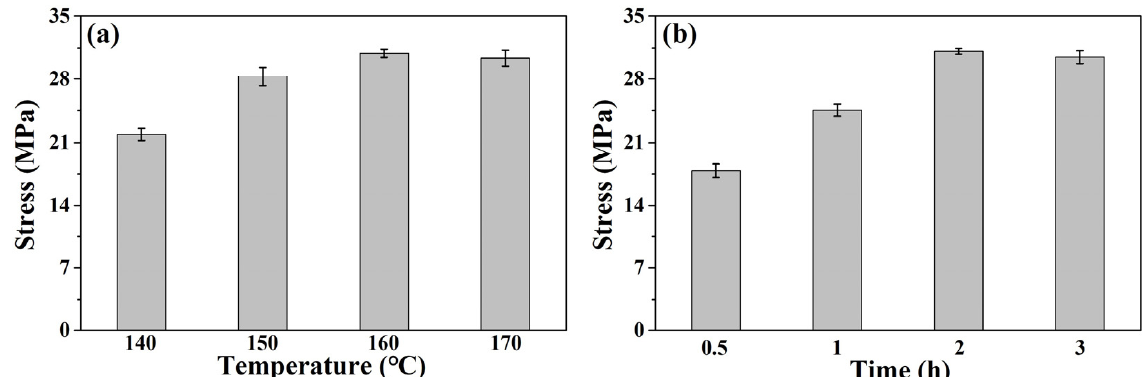
Figure 4. Digital photographs of the reprocessing process and a schematic illustration of the repro- cessing mechanism for OBZ-BDB.